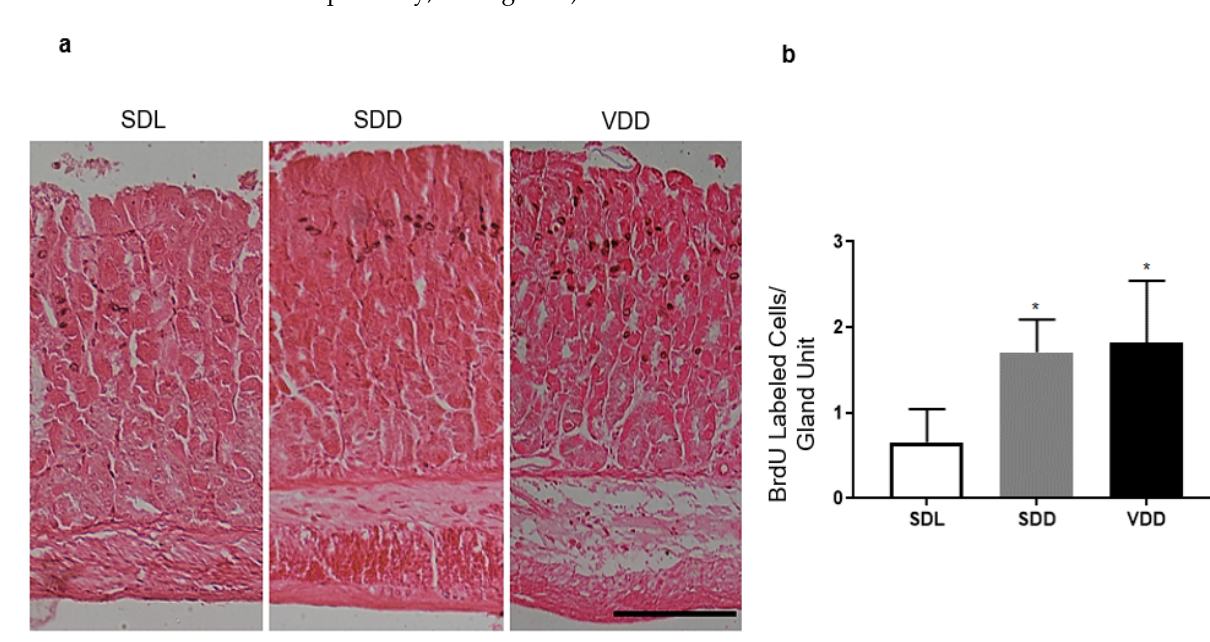
Figure 6. VD deficiency is associated with an increased proliferation. ( a ) Immunohistochemical analysis of BrdU-labeled proliferating cells in the isthmus domain of the corpus gastric gland ( n = 4/group). Scale bar, 200 μ m. ( b ) Increased BrdU-label in the SDD and VDD groups compared with the SDL group. The data analysis was performed using a one-way ANOVA, * p < 0.05.